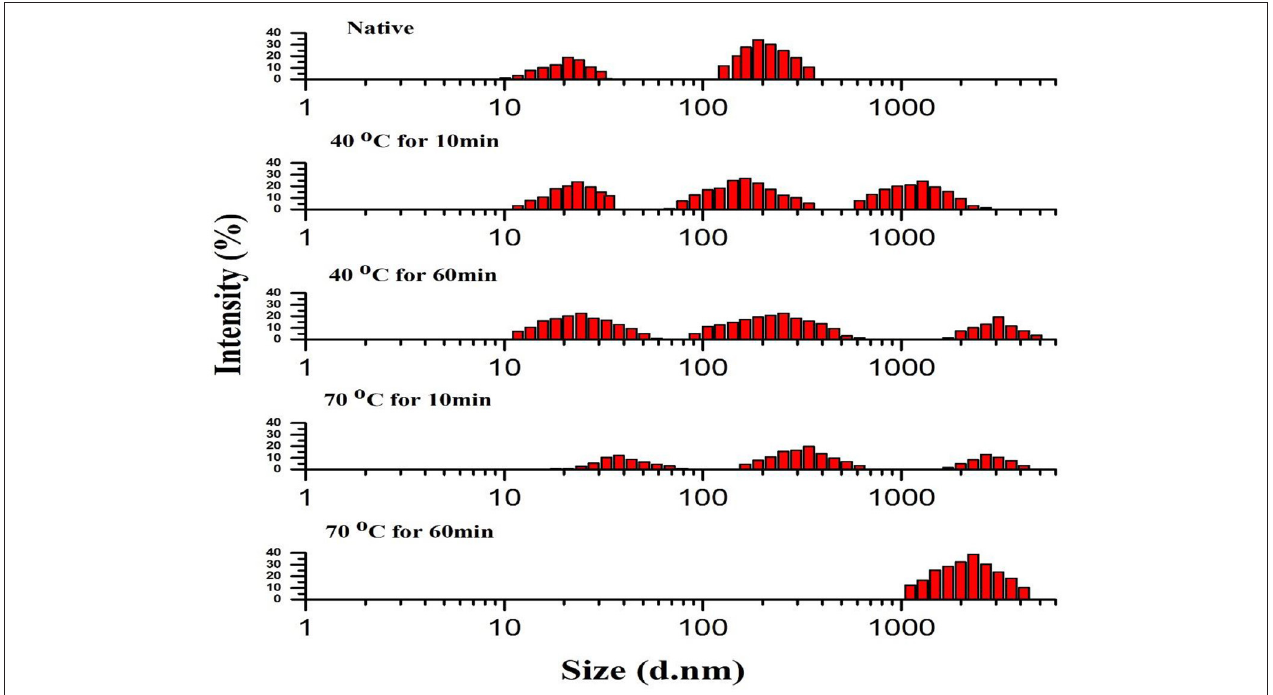
FIGURE 2 | Particle size distribution (PSD) pattern of native and thermally treated PPO. All data were the means ± SD .